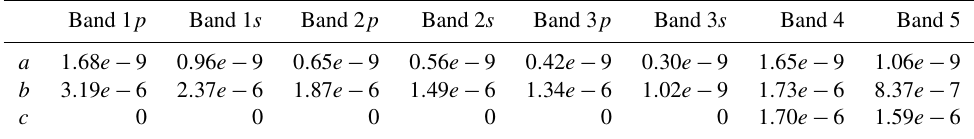
Table 3. Fitting parameters of in-orbit SNR model.